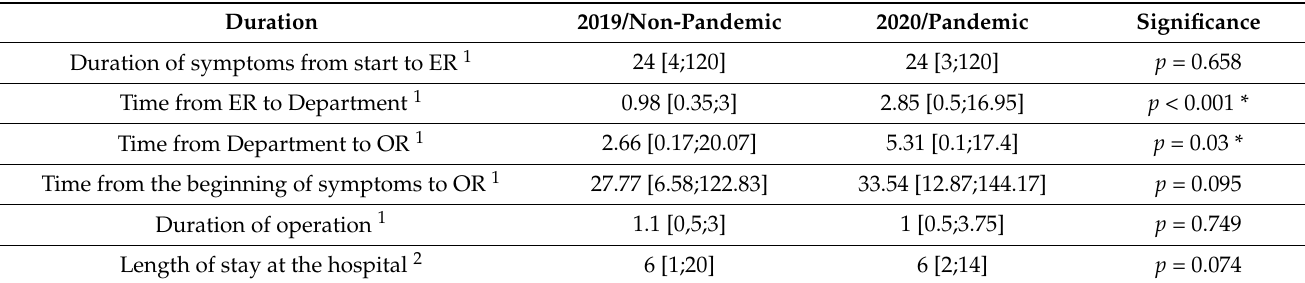
Table 1. Comparison of different time intervals from the beginning of symptoms till arriving at the emergency room, the operating room, and time spent in each department, as well as duration of